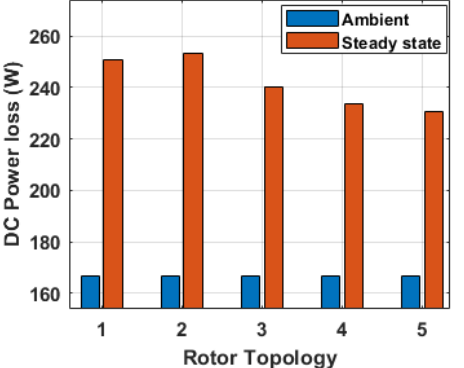
Figure 12. Comparison in terms of DC power losses among the five considered topologies, at both ambient and steady-state temperature conditions.